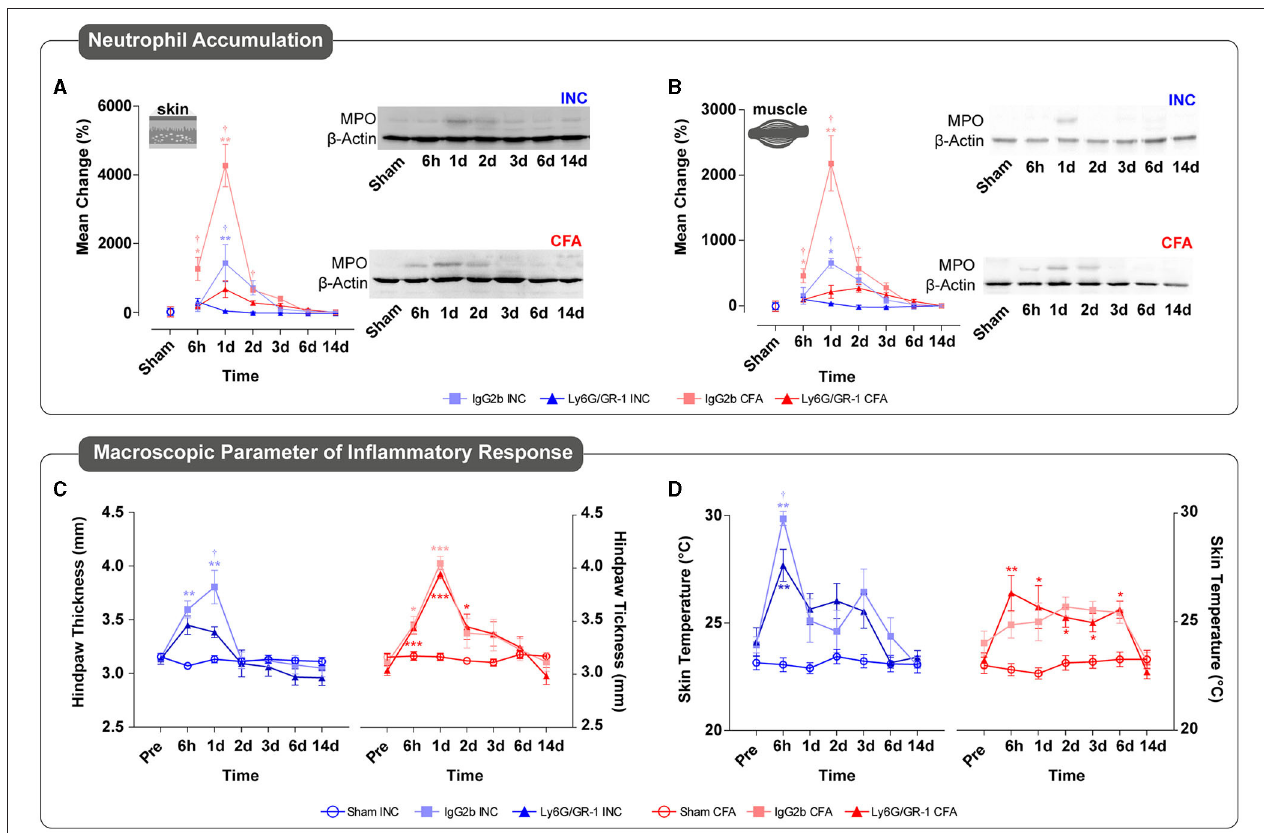
FIGURE 2 | Time-dependent Ly6G + neutrophil (NG) accumulation and macroscopic parameter of inflammatory response in incisional (INC) and inflammatory (CFA) pain models. (A,B) Upon INC and CFA, the NG-specific marker myeloperoxidase (MPO) was significantly increased in the skin (A) and muscle (B) tissue during the acute phase until day 2 after vehicle treatment in cohort 1. The treatment of Ly6G/GR-1 antibody significantly decreased MPO levels, thereby showing the absence of Ly6G + neutrophils. All experimental groups contain four mice (cohort 1). The results are expressed as mean ± SEM. Values of p : * p < 0.05, ** p < 0.01, *** p < 0.001 vs. Sham, † p < 0.05, †† p < 0.01, ††† p < 0.001 vs. Vehicle (IgG2b) by the Kruskal–Wallis test followed by Dunnett’s multiple comparison test. (C,D) INC and CFA induce a significant increase in the inflammatory response, represented by hindpaw thickness (C) and skin temperature (D) in cohort 2. While the inflammatory response with INC was limited to the acute period, CFA induced a longer-lasting response. Neutropenia induced by Ly6G/GR-1 treatment led to a significant decrease in both inflammatory parameters in the acute phase after incision, but no alterations were observed in the CFA group. All experimental groups contain eight mice (cohort 2). The results are expressed as mean ± SEM. Values of p : * p < 0.05, ** p < 0.01, *** p < 0.001 vs. Pre-value, † p < 0.05, †† p < 0.01, ††† p < 0.001 vs. Vehicle (IgG) at the same time point, by Kruskal–Wallis and Dunnett’s multiple comparison